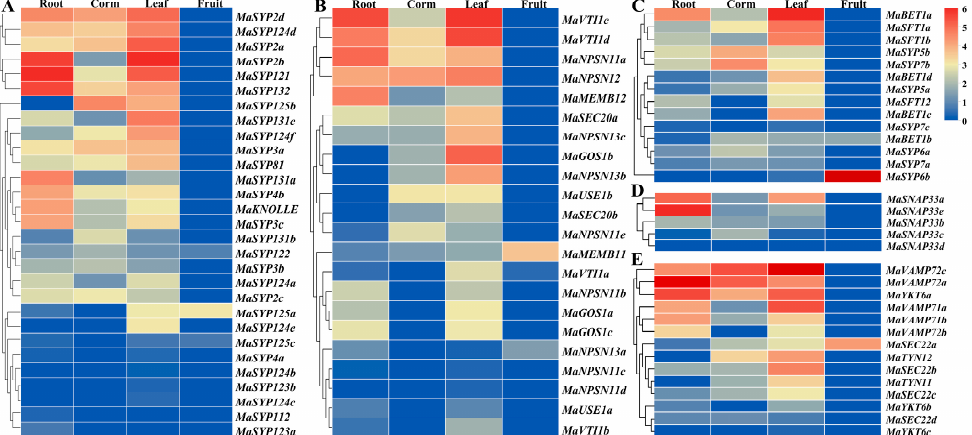
Figure 5. Expression heatmap for MaSNARE genes in different banana organs. ( A – E ) Qa, Qb, Qc, Qbc and R subfamily, respectively. For the heatmap drawing, the average FPKM values of three biological replications were used. The redder the color, the higher the expression level; the bluer, the lower the expression level.